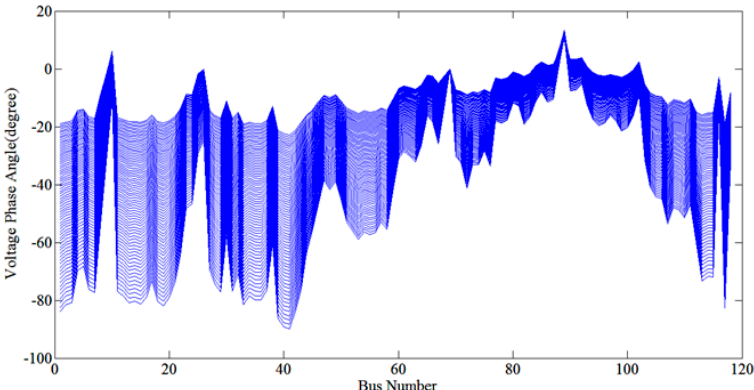
Figure 17. The voltage phasor profile in terms of the load demand increment in the MLP with the IEEE 118-bus test system.